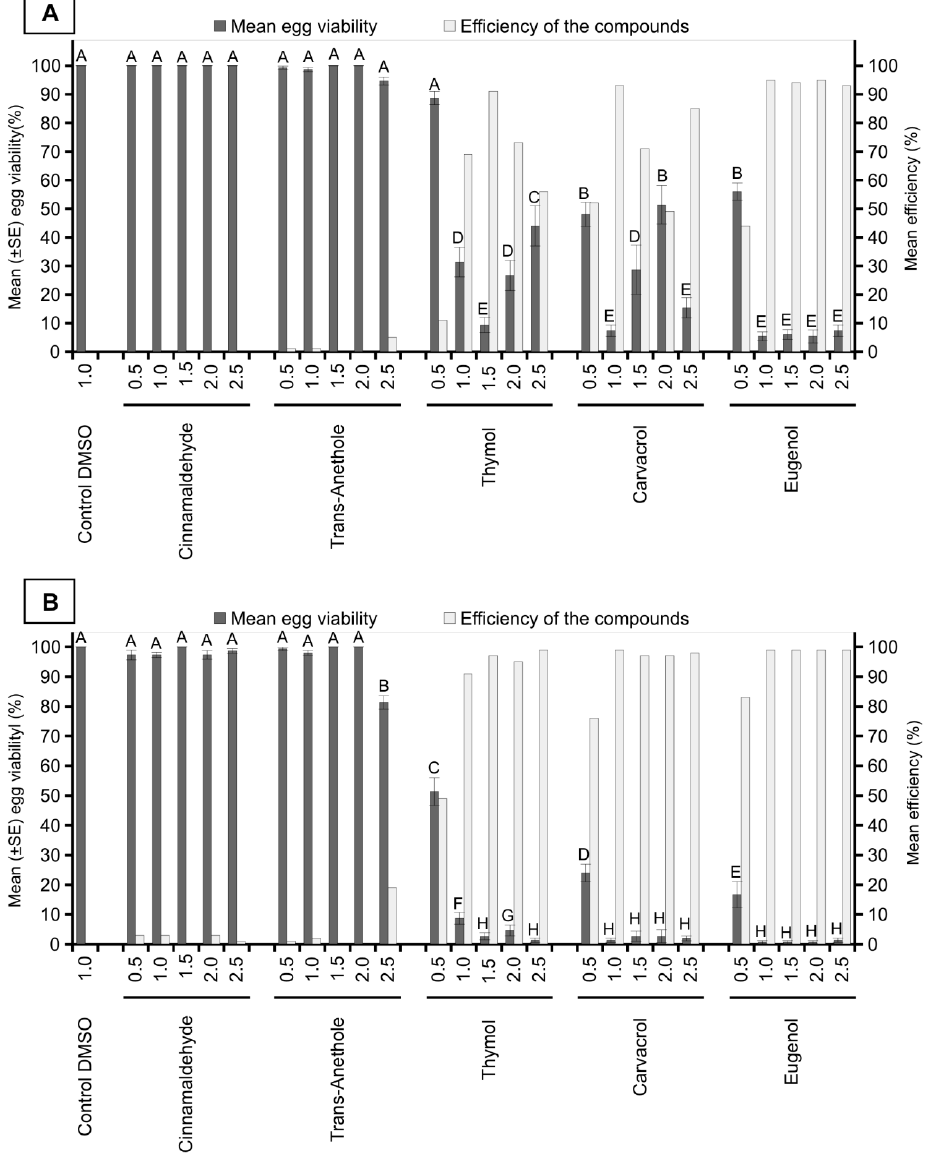
Figure 1. Insecticidal activity of compounds of plant origin (concentrations of 0.5%, 1.0%, 1.5%, 2.0%, and 2.5%) against Mahanarva spectabilis eggs after 24 ( A ) and 48 h ( B ) of application. The control